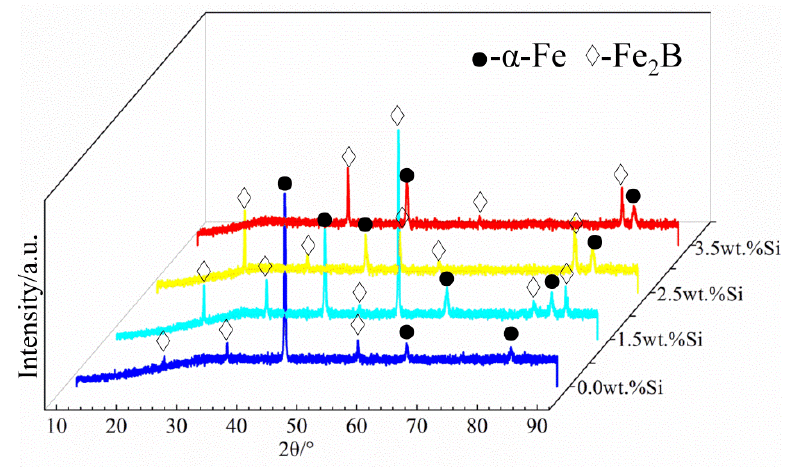
Figure 5. X-ray diffraction patterns of the as-cast DS Fe–B alloys (i.e., longitudinal section).